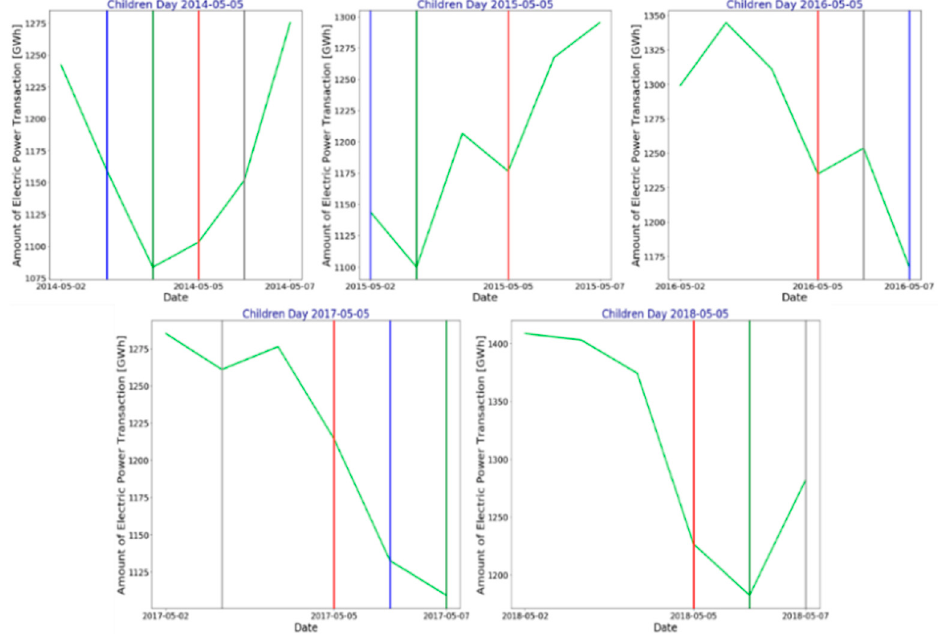
Figure 9. Children’s Day in South Korea during 2014–2018.